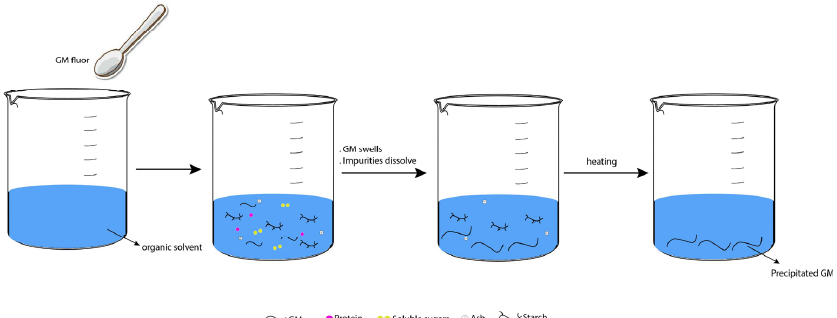
Figure 5. Separation of GM from impurities.